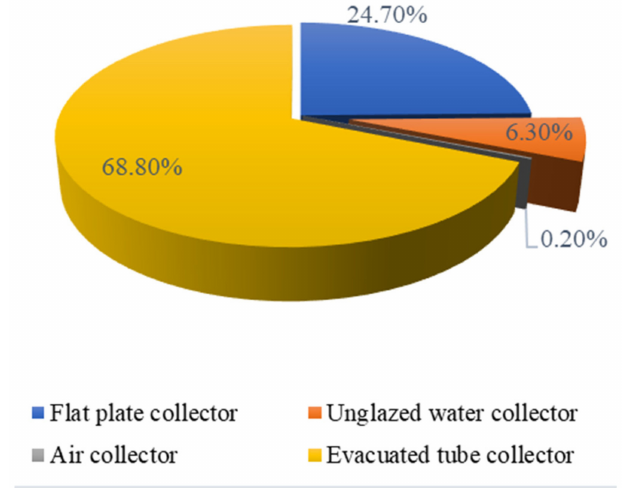
Figure 2. Distribution of the total installed capacity in operation by collector type in 2019— WORLD